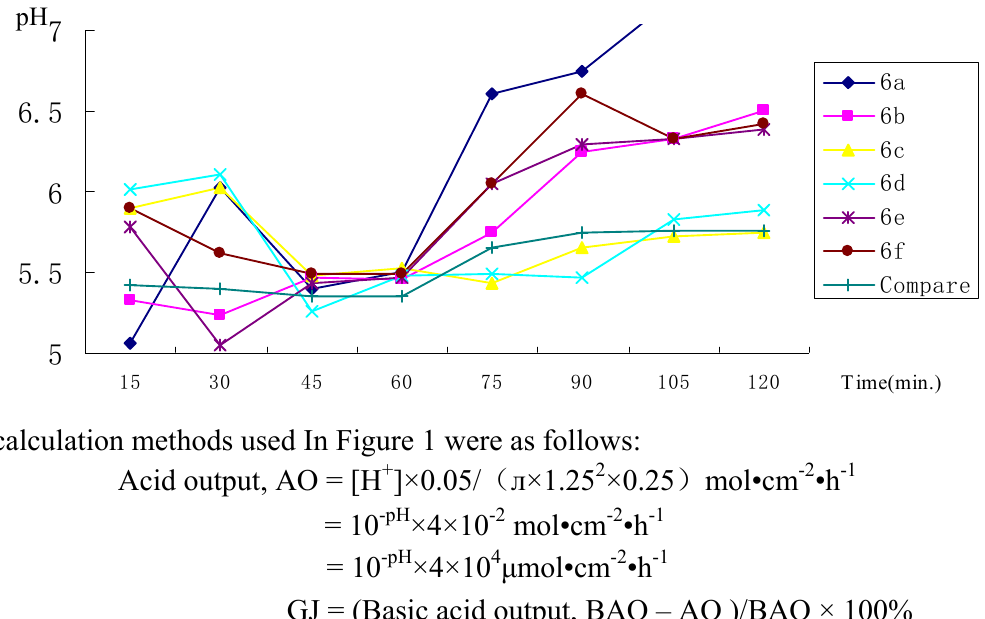
Figure 1. Phenoxypropylamine Effect on Gastric Acid Secretion in the Isolated Guinea